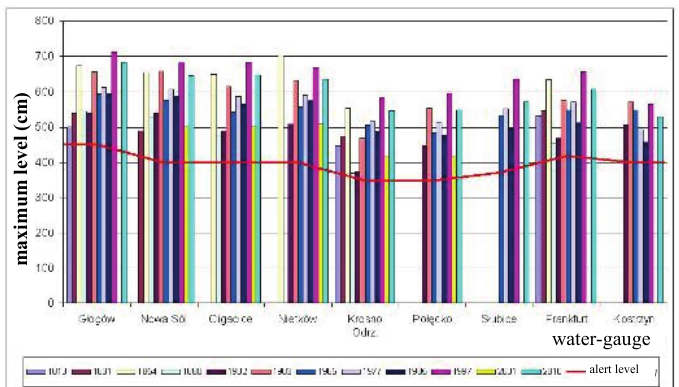
Fig. 2. Large inundations recorded in the Middle Odra river